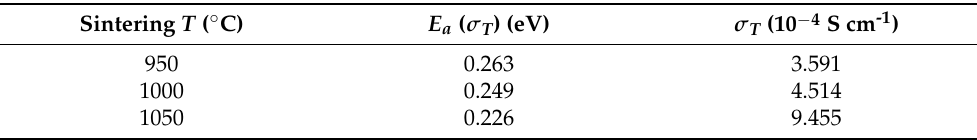
Figure 8. Arrhenius plots of LASTP-750 pellets sintered at various temperatures. Table 4. The activation energies and ionic conductivities of the LASTP pellets sintered at various